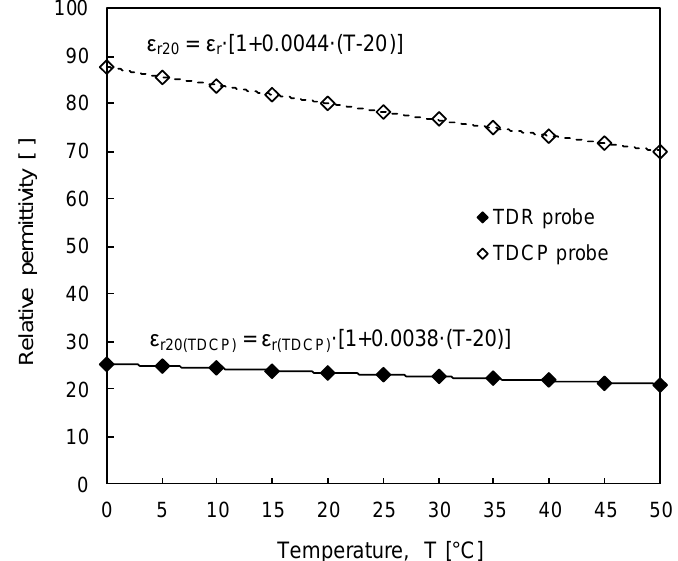
Figure 8. Relative permittivities of distilled water at different temperatures evaluated by using the TDR probe and TDCP probe.